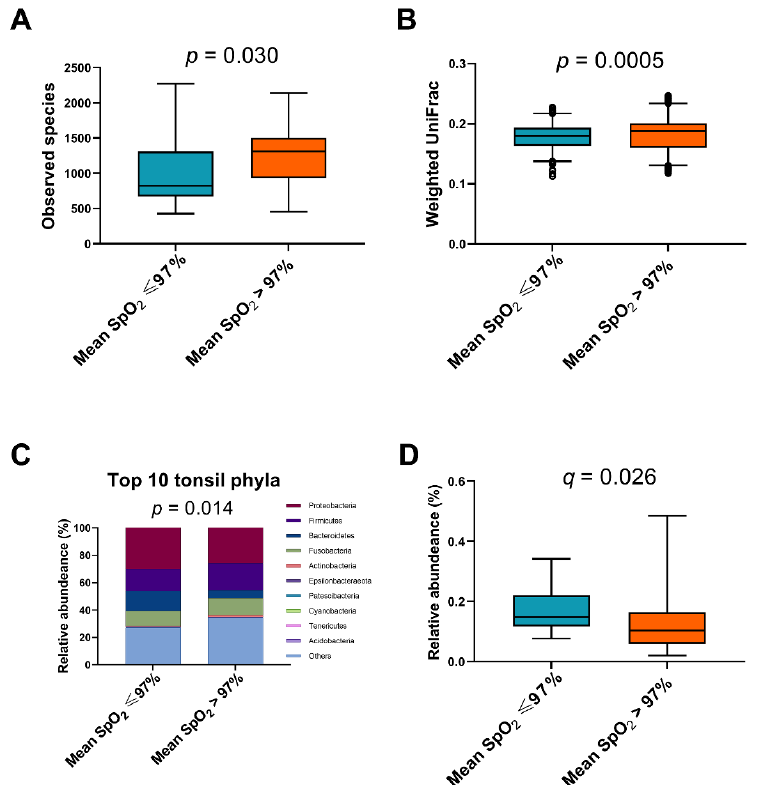
Figure 4. Comparison of the tonsil microbiome between the mean oxygen saturation (SpO 2 ) ≤ 97% and > 97% subgroups. ( A ) The α diversity of the mean SpO 2 ≤ 97% subgroup was significantly lower than that of the mean SpO 2 > 97% subgroup ( p = 0.030; Mann–Whitney U test). ( B ) The β diversity of the mean SpO 2 ≤ 97% subgroup was significantly lower than that of the SpO 2 > 97% subgroup ( p = 0.0005; Mann–Whitney U test). ( C ) The relative abundances of the top 10 tonsil phyla in the mean SpO 2 ≤ 97% subgroup were significantly different from those in the mean SpO 2 > 97% subgroup ( p = 0.014; analysis of similarity test). ( D ) Furthermore, the relative abundance of Bacteroidetes in the mean SpO 2 ≤ 97% subgroup was significantly higher than that in the mean SpO 2 > 97% subgroup ( q = 0.026; Mann–Whitney U test).